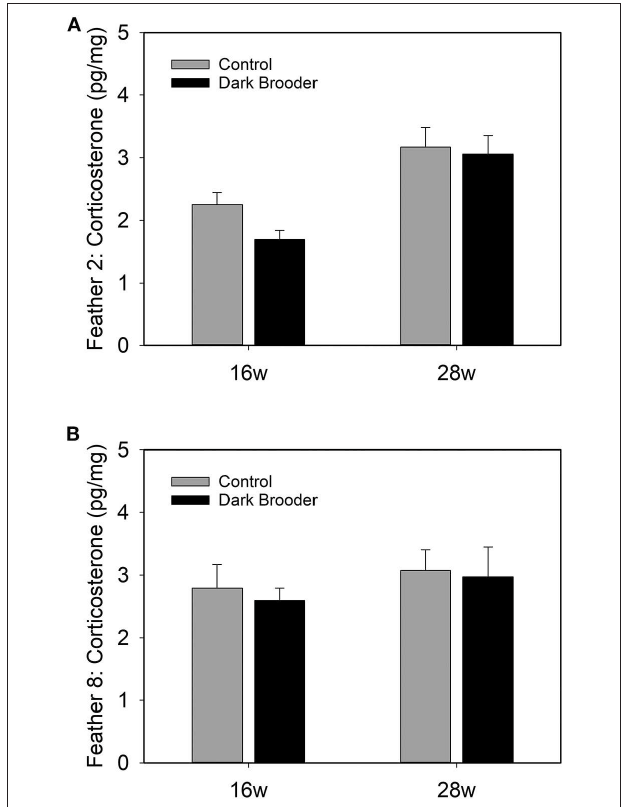
FIGURE 2 | Bars indicate concentrations of CORT in pg per mg of feather vane measured in primary wing feather 2 (A) and primary wing feather 8 (B) from hens at 16 weeks (16w) and 28 weeks (28w) of age. Bars indicate average, error bars indicate SEM.